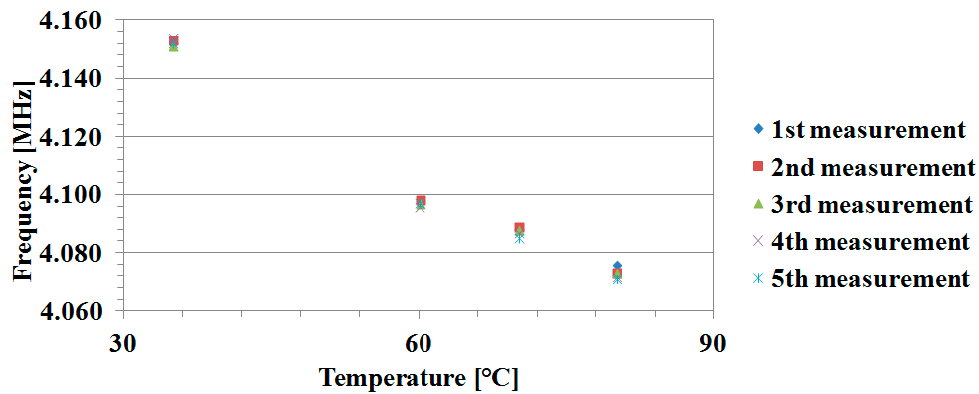
Figure 12. Temperature dependency of the forced frequency used for the zero-offset calibration.